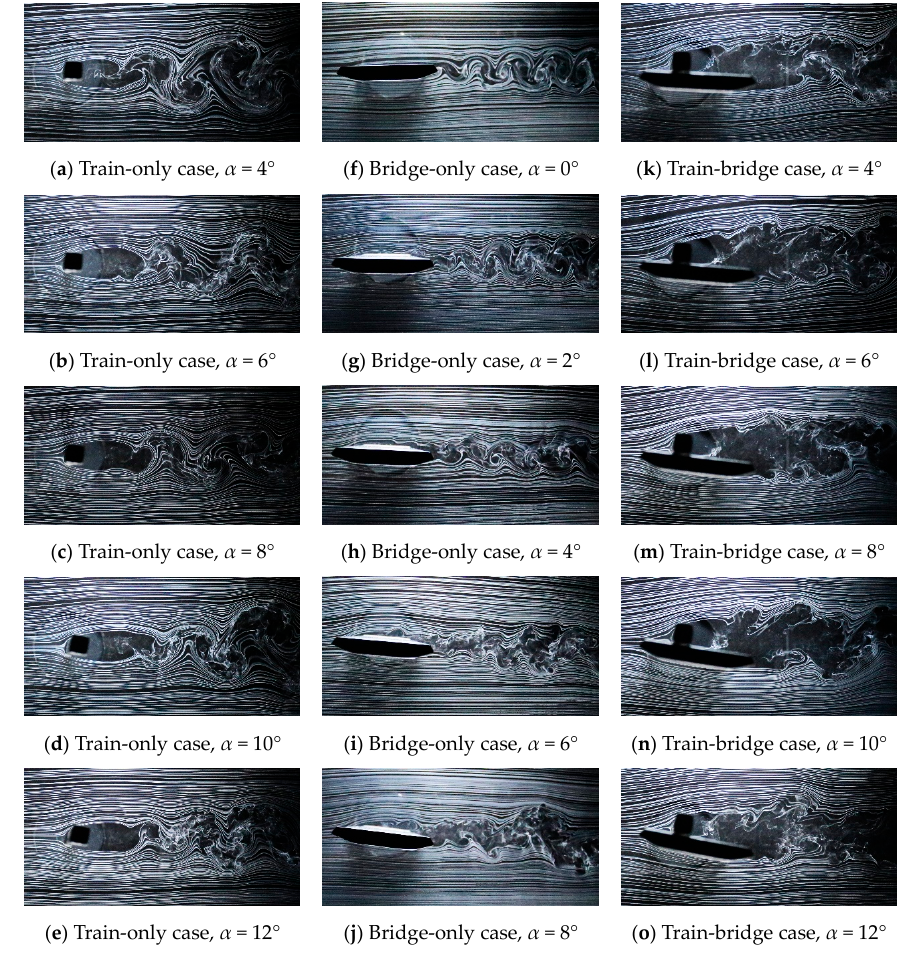
Figure 4. Instantaneous flow patterns: ( a – e ) Train-only case at α = 4°~12°, ( f – j ) Bridge-only case at α = 4°~12°, and ( k – o ) Train-bridge case at α = 0°~8°.